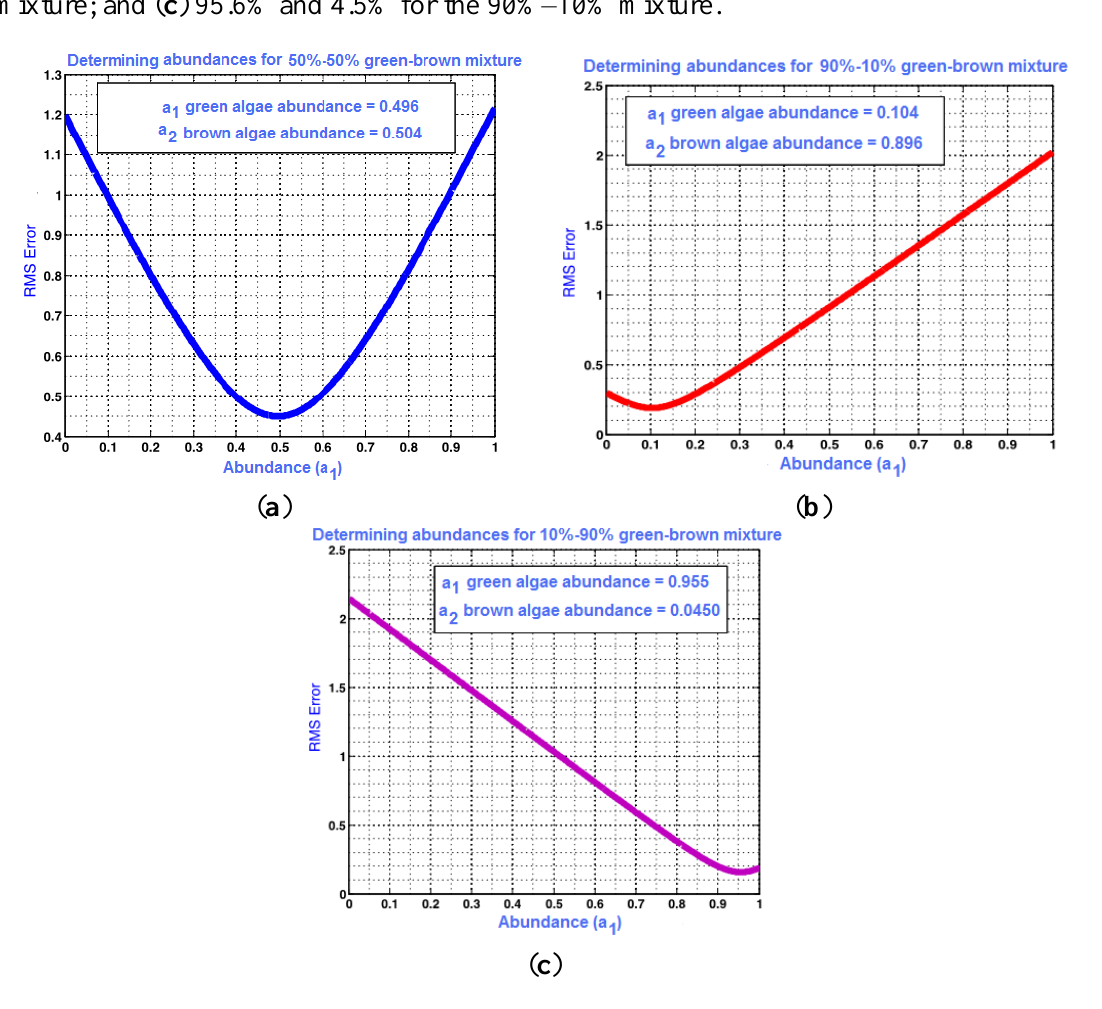
Figure 7. Computed abundances from algae mixture hyperspectral measurements based on the minimum error between assumed abundances and pure (single-algae) spectral combinations. The combined volumes for the green and brown algae were found to be ( a ) 10.4% and 89.6% for 10%–90% mixture; ( b ) 49.6% and 50.4% for the